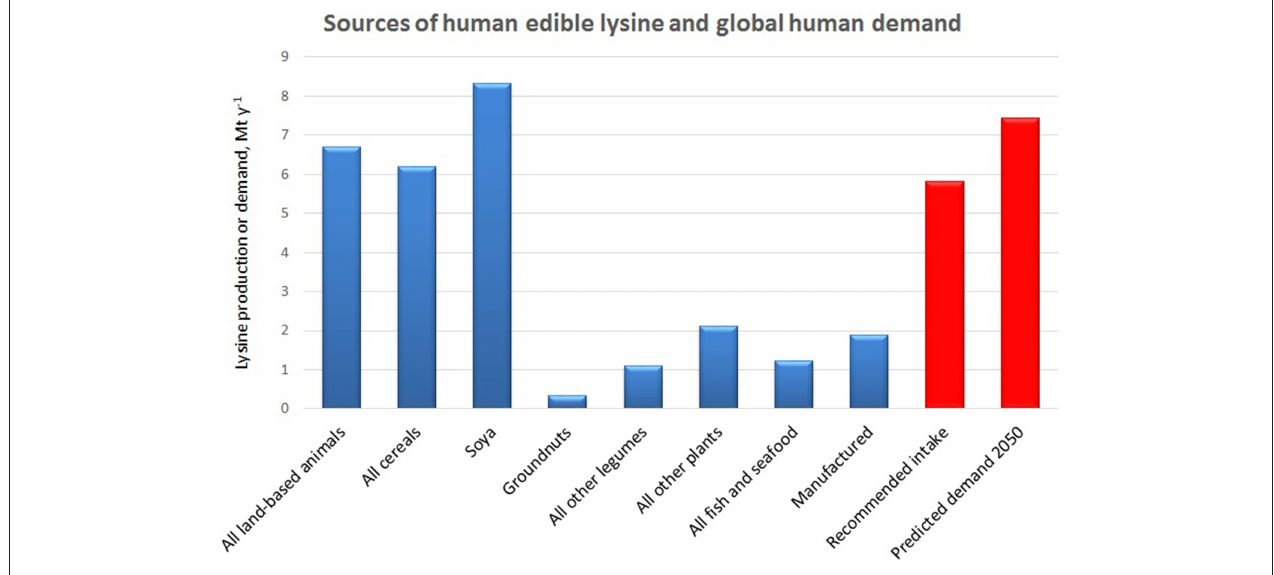
FIGURE 5 | Global production of potentially human edible lysine from animal products, soya, groundnuts, all other legumes, all cereals, all other plant-based protein (FAOSTAT, 2018) and other sources [manufactured lysine, according to 2014 data (Global Market Insights, 2015; Grand View Research, 2015)]. The estimate for fish and seafood is based on the FAOSTAT protein supply data ( FAOSTAT, 2018), as global production data were not available in the FAO statistics. The current global demand for human consumption based on intake recommendations and the estimated demand in 2050, following the predicted population growth, are also